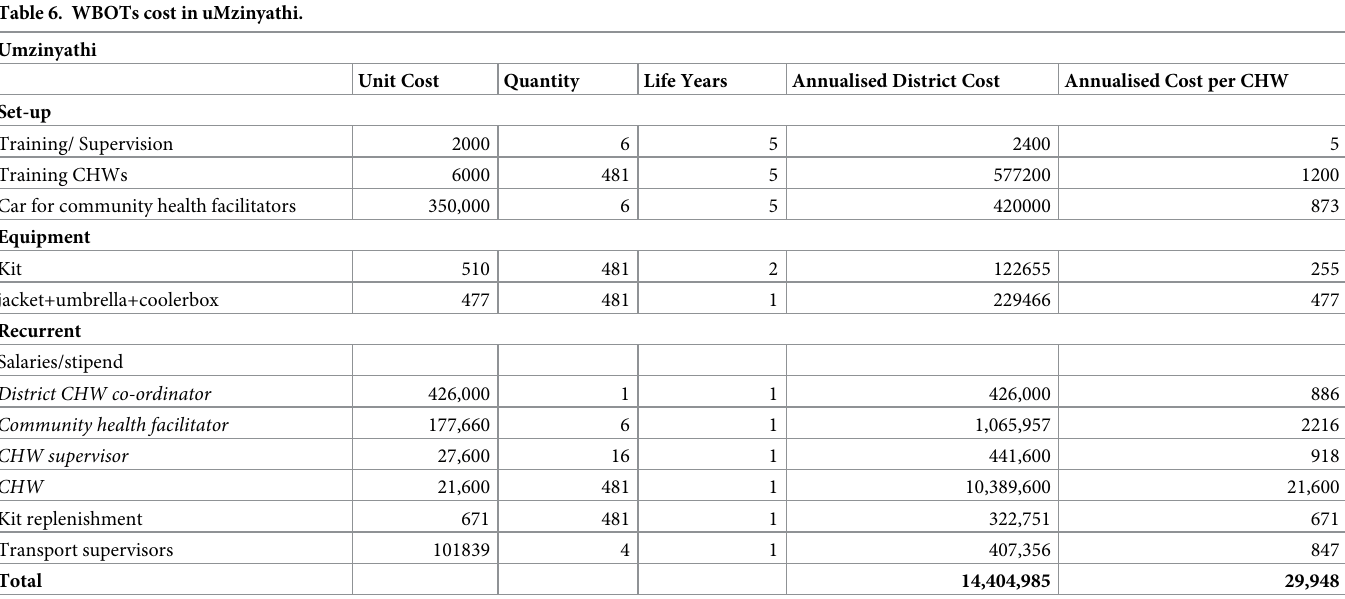
Table 6. WBOTs cost in uMzinyathi.